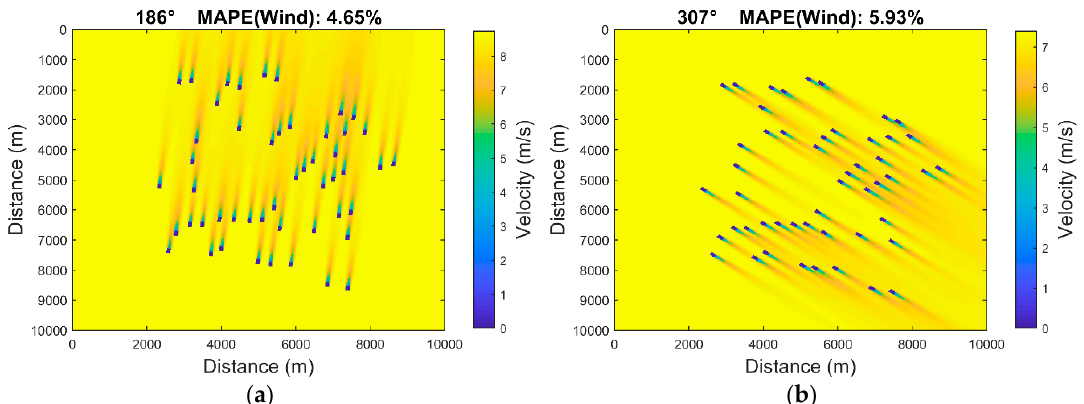
Figure 2 . Gaussian-based analytical wake model flow field prediction for wind direction: ( a ) 186° and ( b ) 307°.